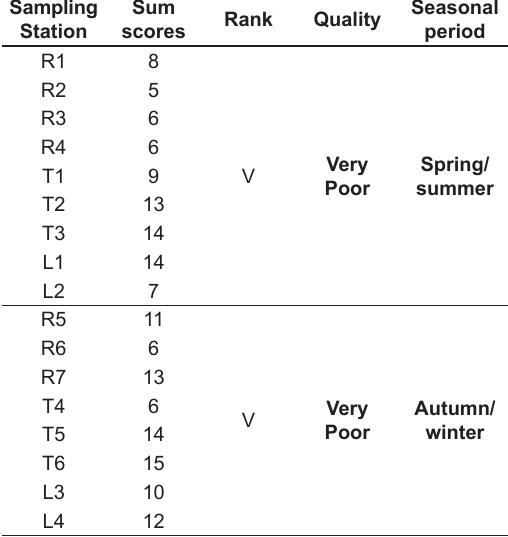
Table 6. Values of the adapted BMWP and water quality ranking system based on benthic macroinvertebrates to the sampling stations of Itupararanga.